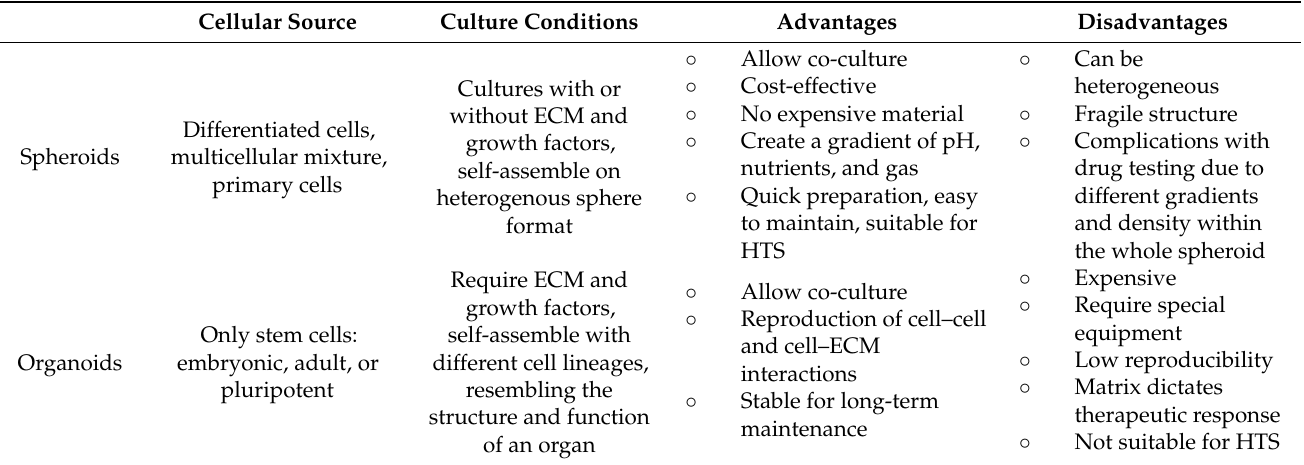
Table 2. Stroke models in vitro: comparison of spheroids and organoids, in terms of culture and their advantages and